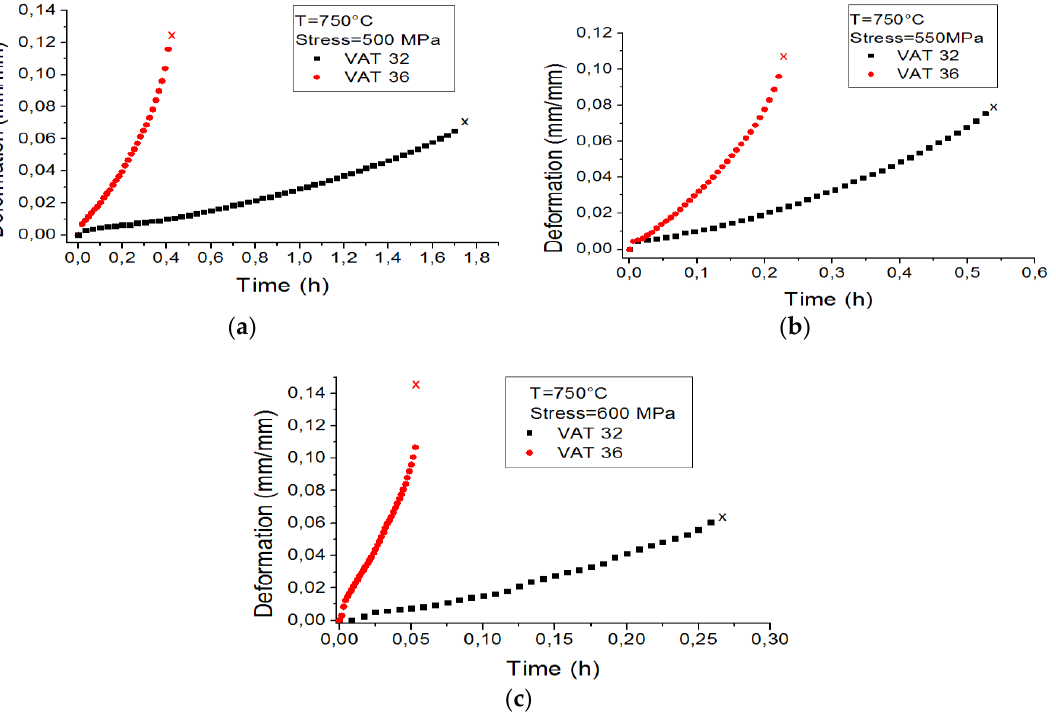
Figure 10. Creep curves of the alloys VAT 36 and VAT 32 the 750 °C at the stress of: ( a ) 500. ( b ) 550 and ( c ) 600 MPa.